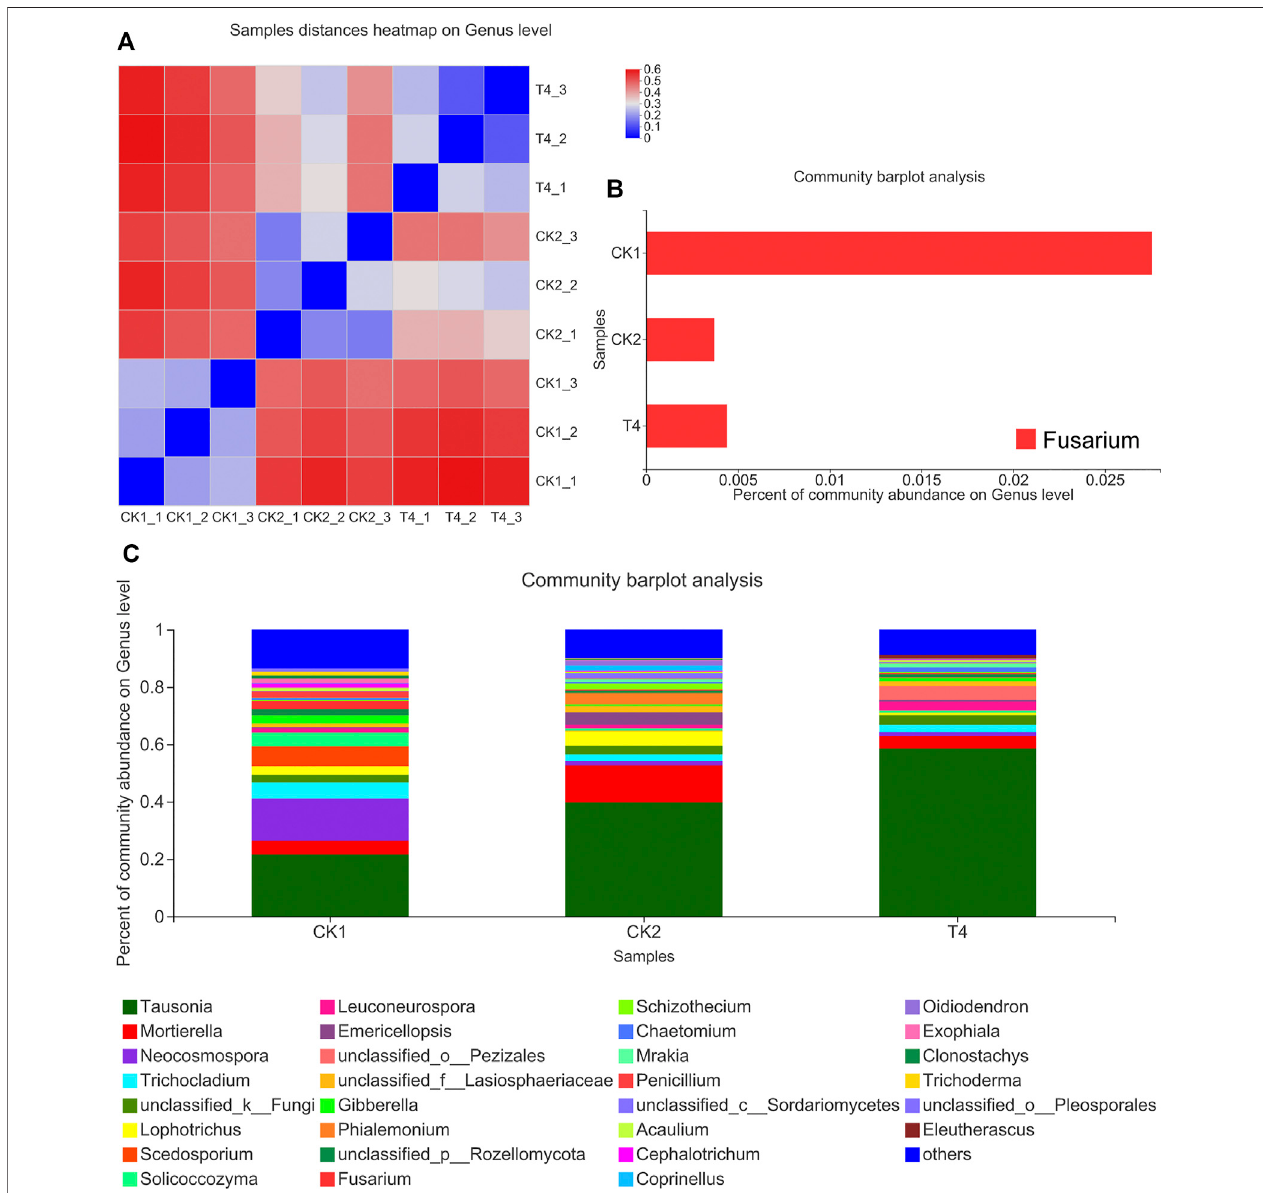
FIGURE4| Changesoffungalcommunity compositionaftersoakingsoil. (A) SamplesdistancesheatmaponGenuslevel.Boththe X and Y axesaresamples,and the distance between samples is represented by different color gradients (the right side of the fi gure is the value represented by the color gradient). (B) Community barplot analysis of single Fusarium . (C) Percent of community abundance on Genus level. The abscissa is the sample name, and the ordinate is the proportion of the species in the sample. The columns of different colors represent different species, and the length of the columns represents the proportion of the species. CK1: control, CK2: high standard control, T4: soil